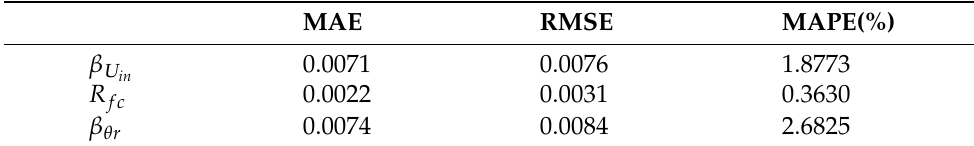
Table 5. RUL prediction result evaluation of ACS-ELM.